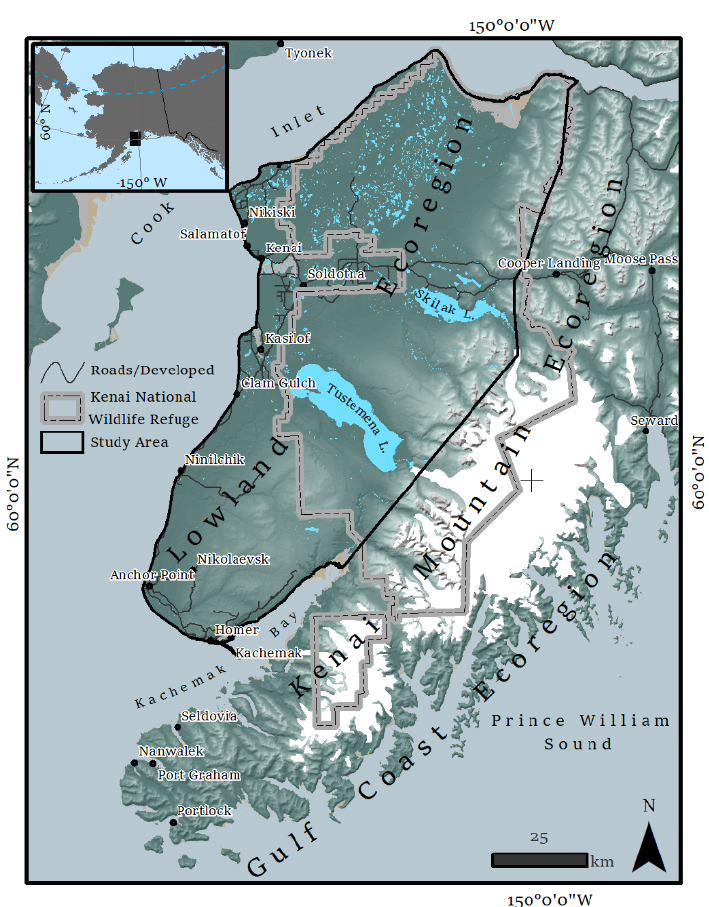
Figure 1. Location of Kenai Peninsula and study area (black) and extent of the Kenai National Wildlife Refuge (grey).